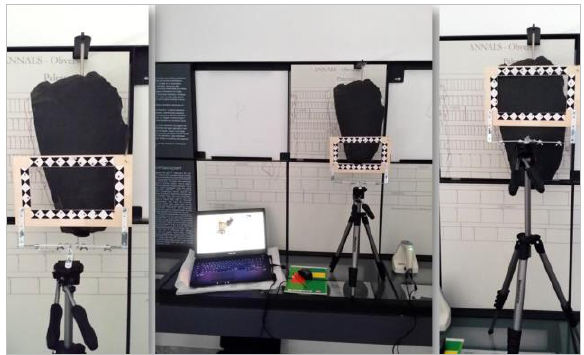
Figure 2: Acquisition phases via 3-D scanning of the Palermo Stone.